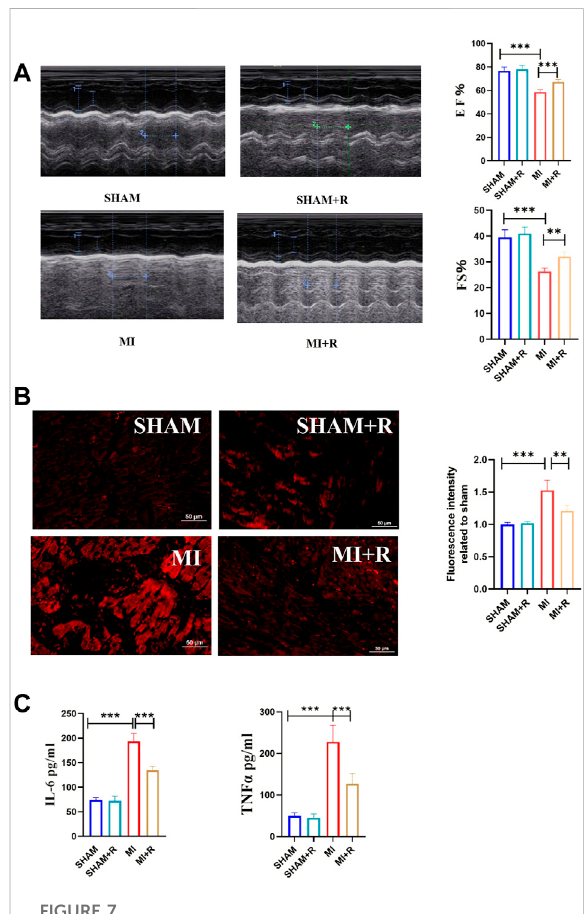
FIGURE 7 RSYRD can reduce the production of ROS, and in fl ammatory cytokinelevelsandimproveheartfunction. (A) EFandFSofmicein four groups (mean ± SD, n = 5). (B) ROS fl uorescence intensity of mice hearttissue in four groups(mean ± SD,n=3). (C) Levels ofIL-6 and TNF-ain serum of mice infour groups (mean ± SD, n = 5). **, p < 0.01; ***, p < 0.001; Scale bars: 50 μ